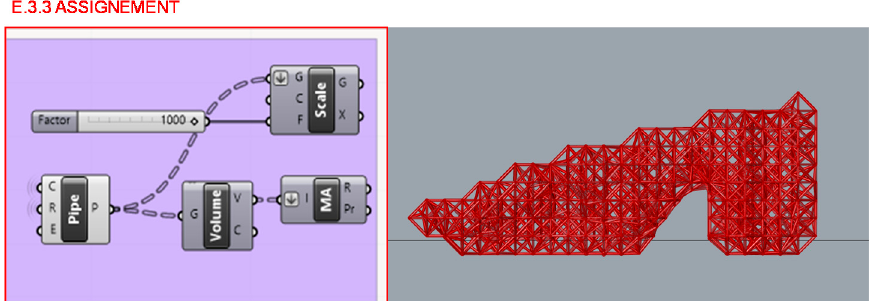
Figure 34. ( a ) Programming structure definition of diameter assignment to the circular cross sections of the structure bars calculated in step E.3.2. ( b ) Preview of the lattice structure result in the Rhinoceros interface.